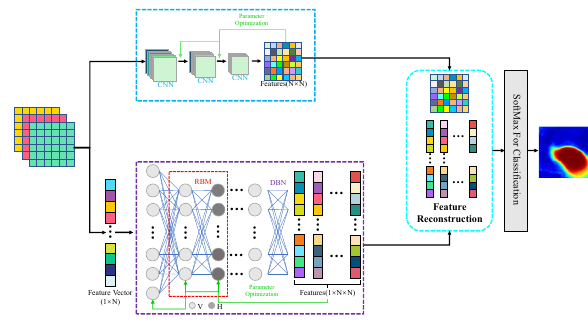
Figure 4. The joint network expands all the shallow